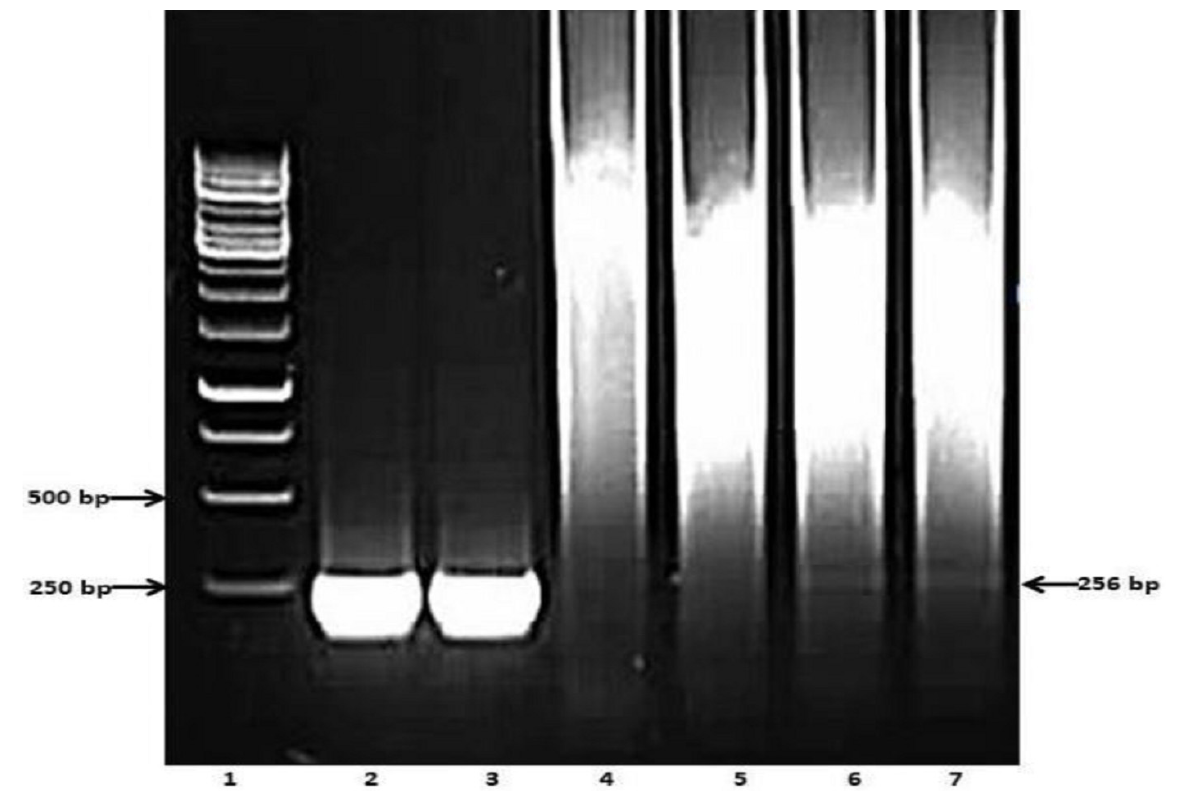
Figure 5. Serum PCR amplification of tRNA (uracil-5-)-methyltransferase yields a common DNA band among core Brucella species. Differences between species is acknowledged only after submission of the DNA band for sequencing and correlating a SNP combination of two nucleotides within this sequence as fingerprints of the Brucella agent (Figure 2). Lane 1—GeneRuler 1kb DNA ladder. Lane 2—A positive control, genomic DNA from an Israeli field strain (DNA sequence proven to be B. melitensis ). Lane 3—A positive control, genomic DNA from B. abortus strain 19 (DNA sequence proven to be B. abortus ). Lane 4—A negative control sample. Lane 5—Serum 4002118, negative. Lane 6—Serum 4813646, Lane 7—Serum 3991347. Positive DNA bands confirmed as B. melitensis are indicated by an arrow. Table 2. Serum PCR analysis of sheep from a flock partially vaccinated with Rev. 1 *.